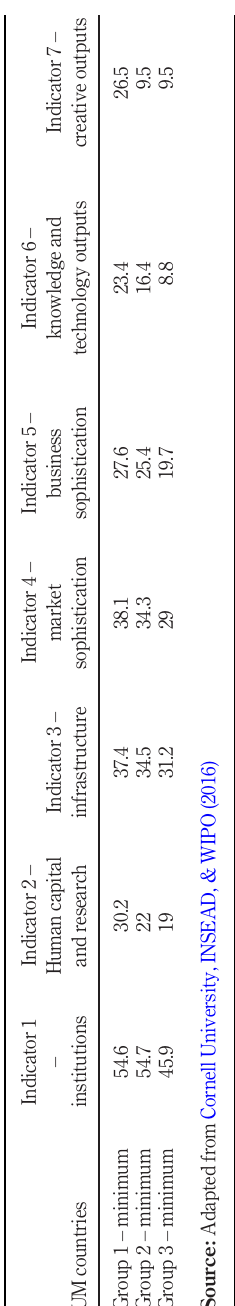
Table 10. Scores ’ validation